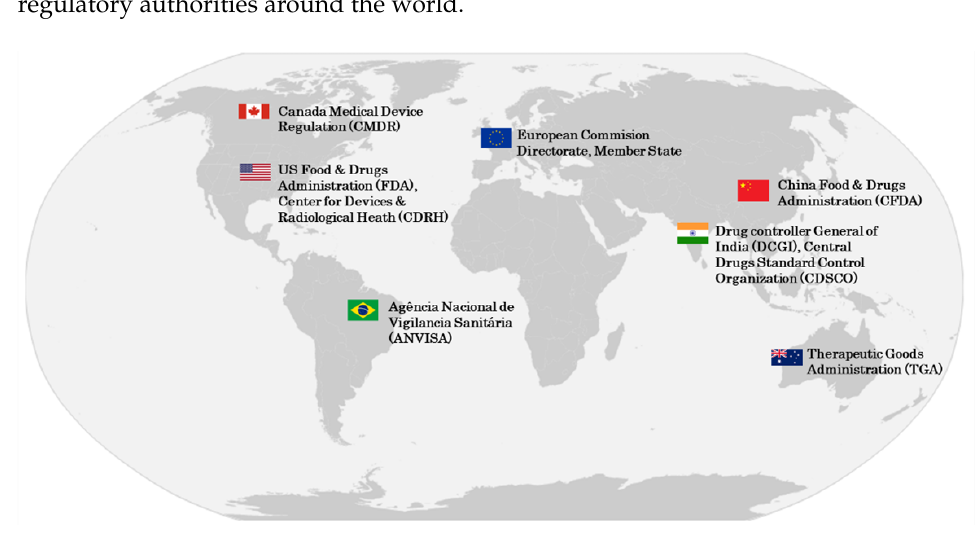
Figure 1. Regulatory authorities around the